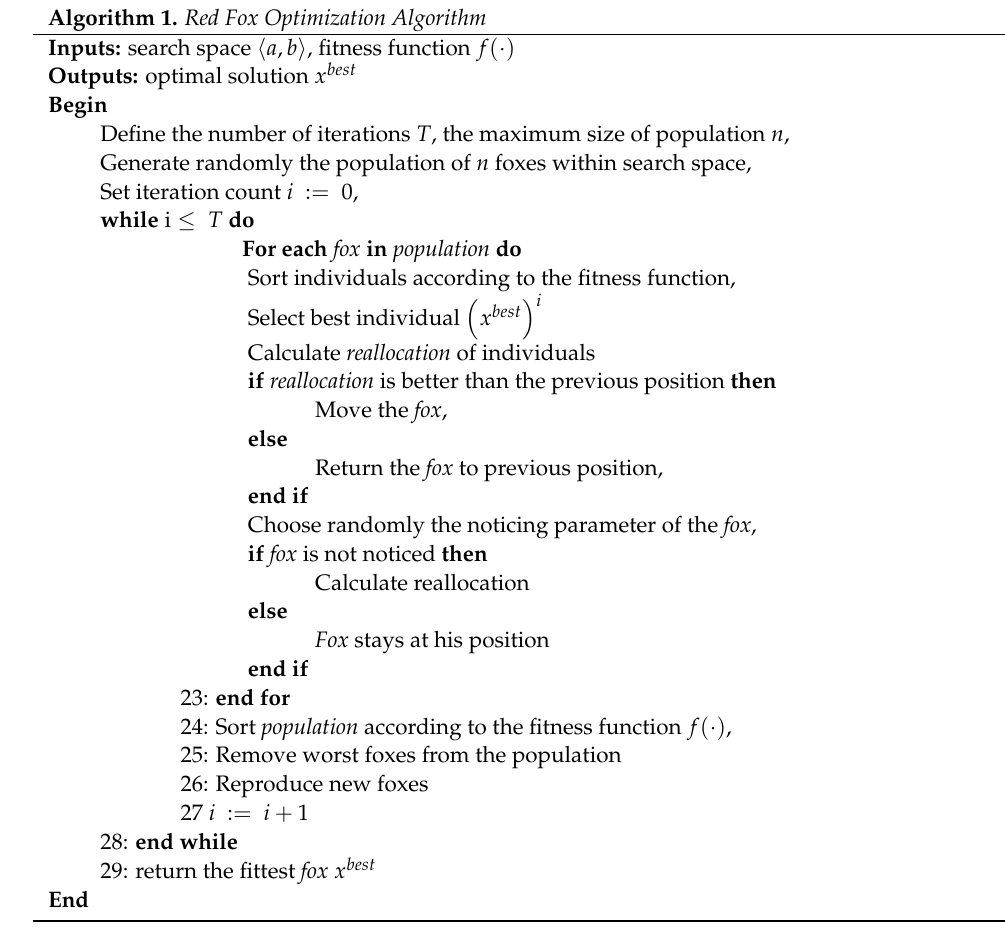
Algorithm 1. Red Fox Optimization